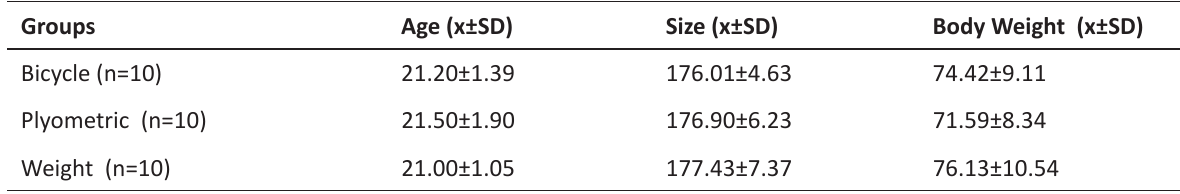
Table 1. The statistical analysis of the age (years), size (cm) and body weight (kg) of the groups Groups